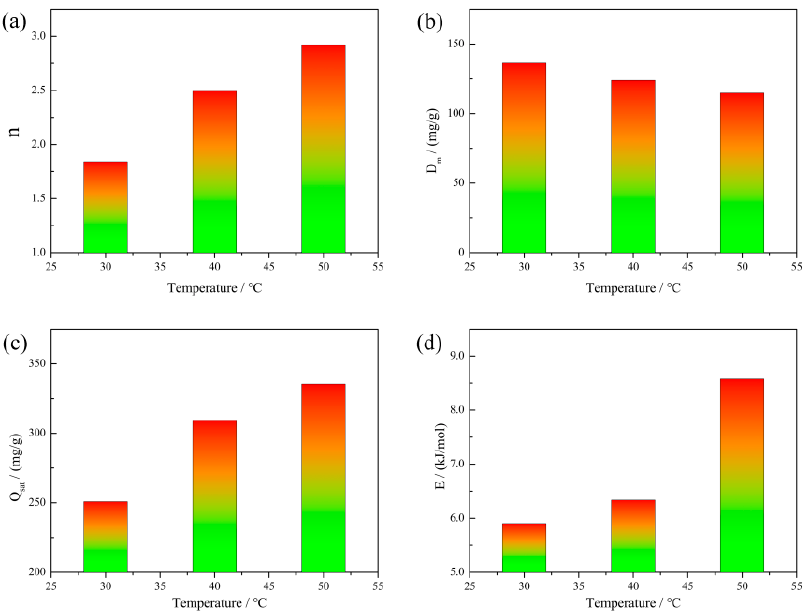
Figure 9. ( a ) The effect of the temperature on the number of molecules per site, ( b ) the density of receptor sites, ( c ) the adsorption capacity at saturation, and ( d ) the adsorption energy of WSO-5.